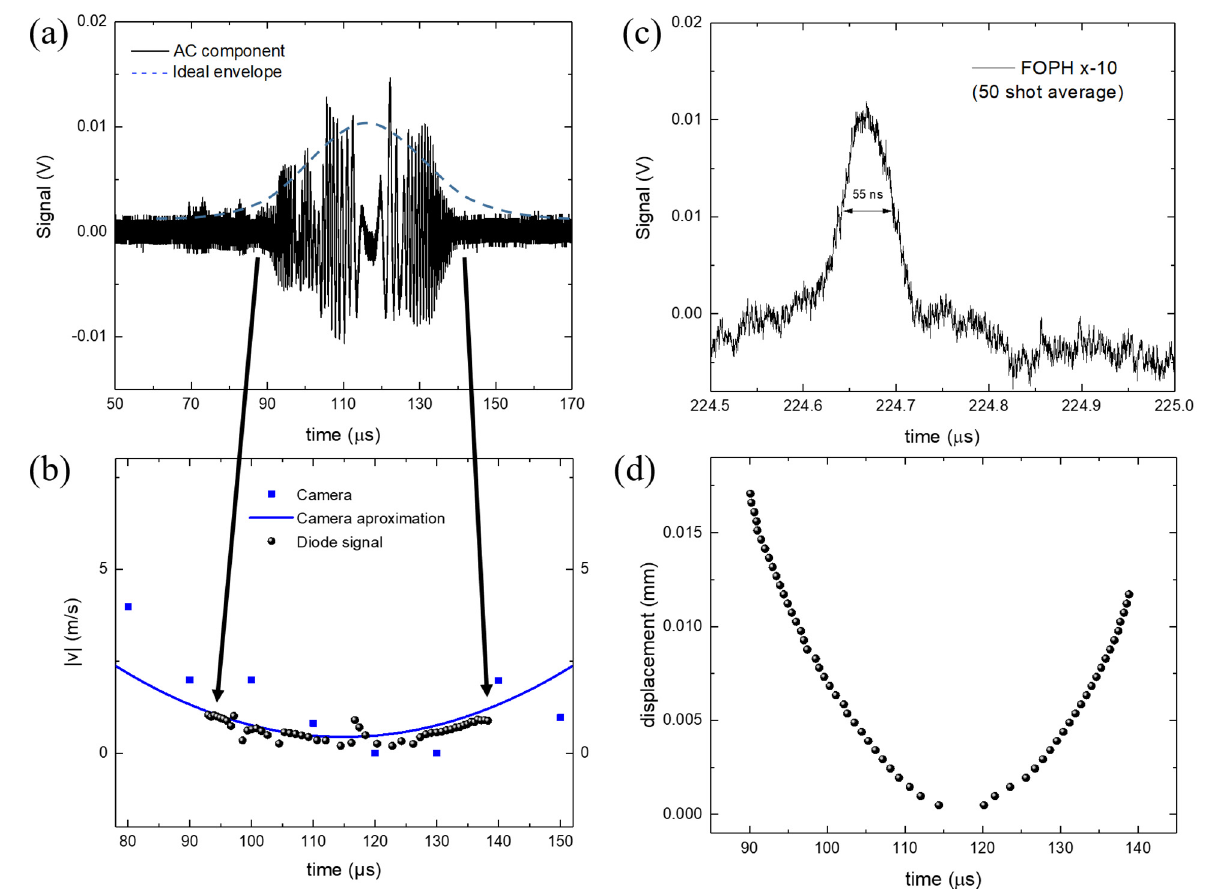
Figure 4. ( a ) AC component of the measured signal; ( b ) bubble wall absolute velocity; ( c ) detail of the bubble collapse shockwave, averaged over 50 measures; ( d ) displacement of the bubble wall relative to the tip position. In all graphs, the time origin is at the initialization of the bubble.